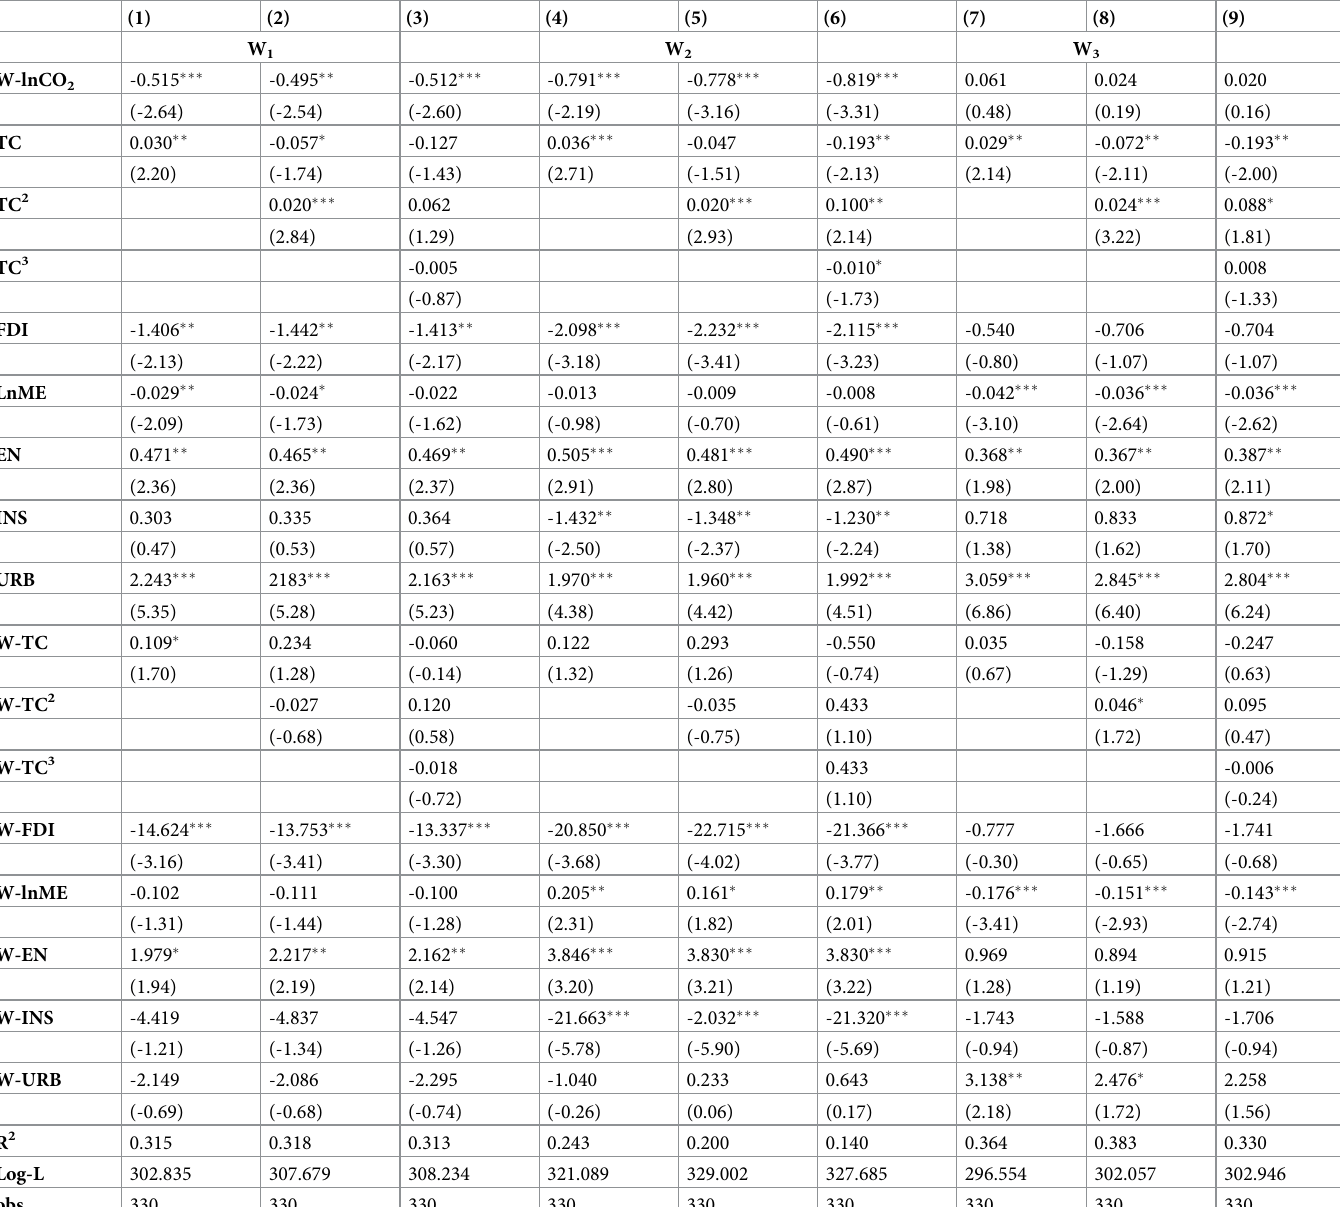
Table 11. Estimation results of